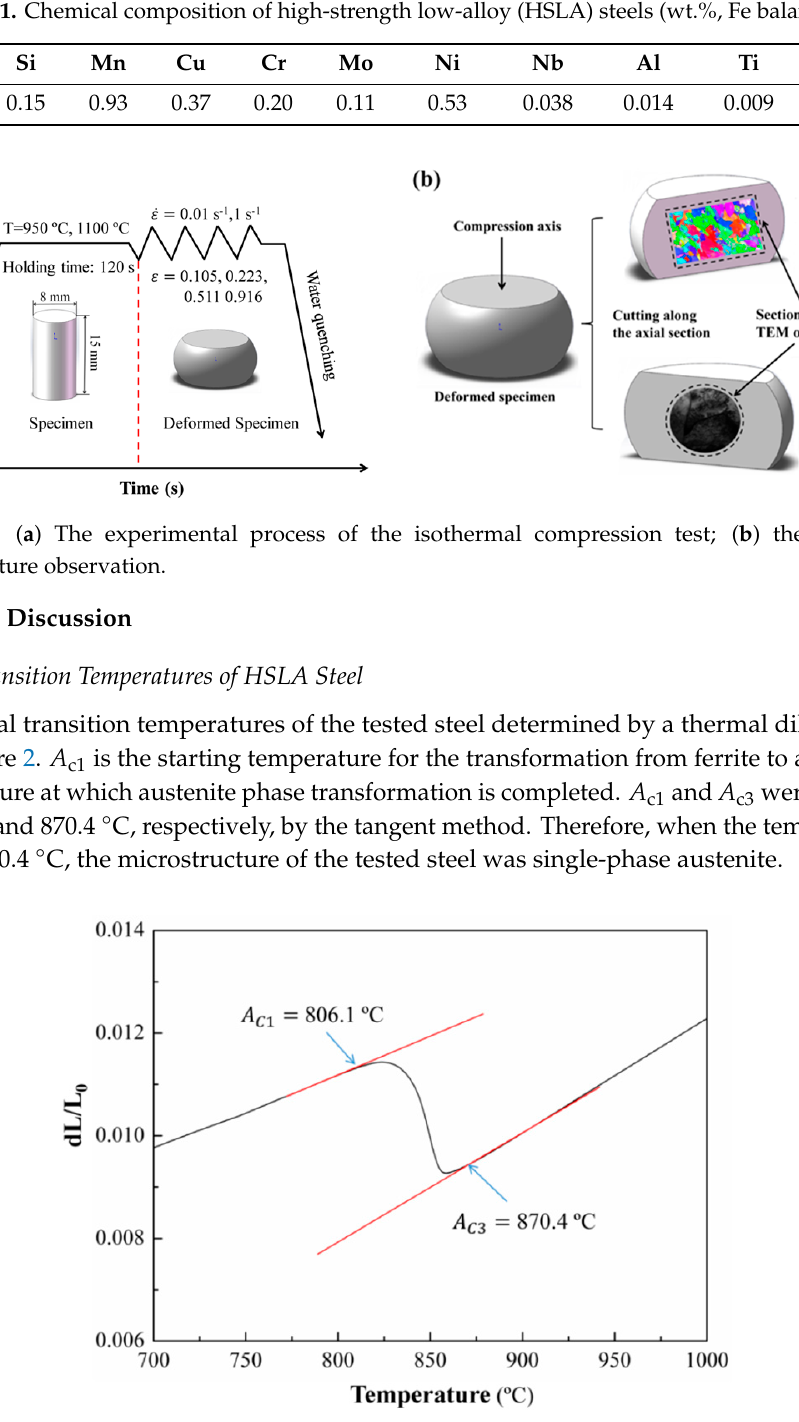
Figure 2. Thermal dilatometric curve of the HSLA steel.